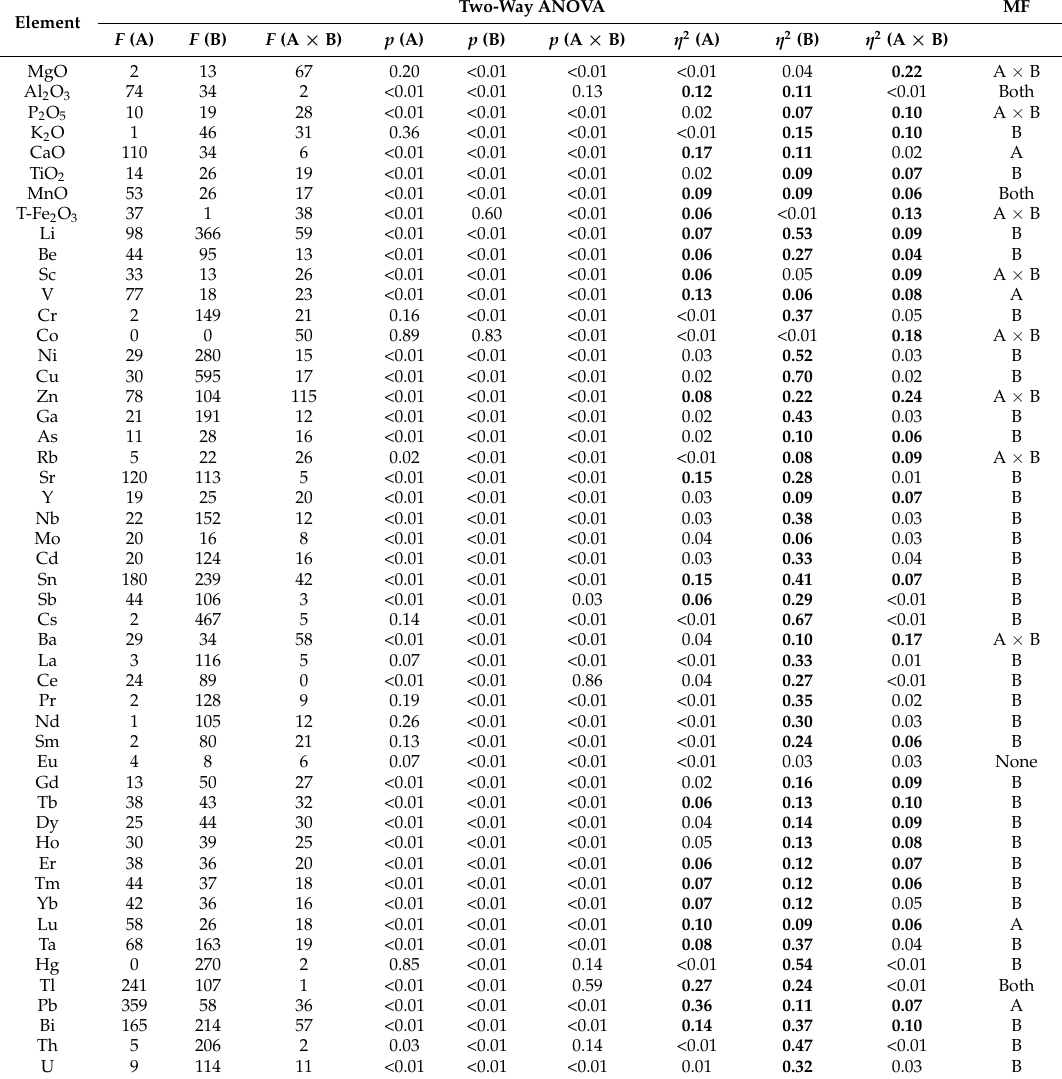
Table 4. Variance ratio ( F ), probability ( p ), and size effect ( η 2 ) of two-way ANOVA type